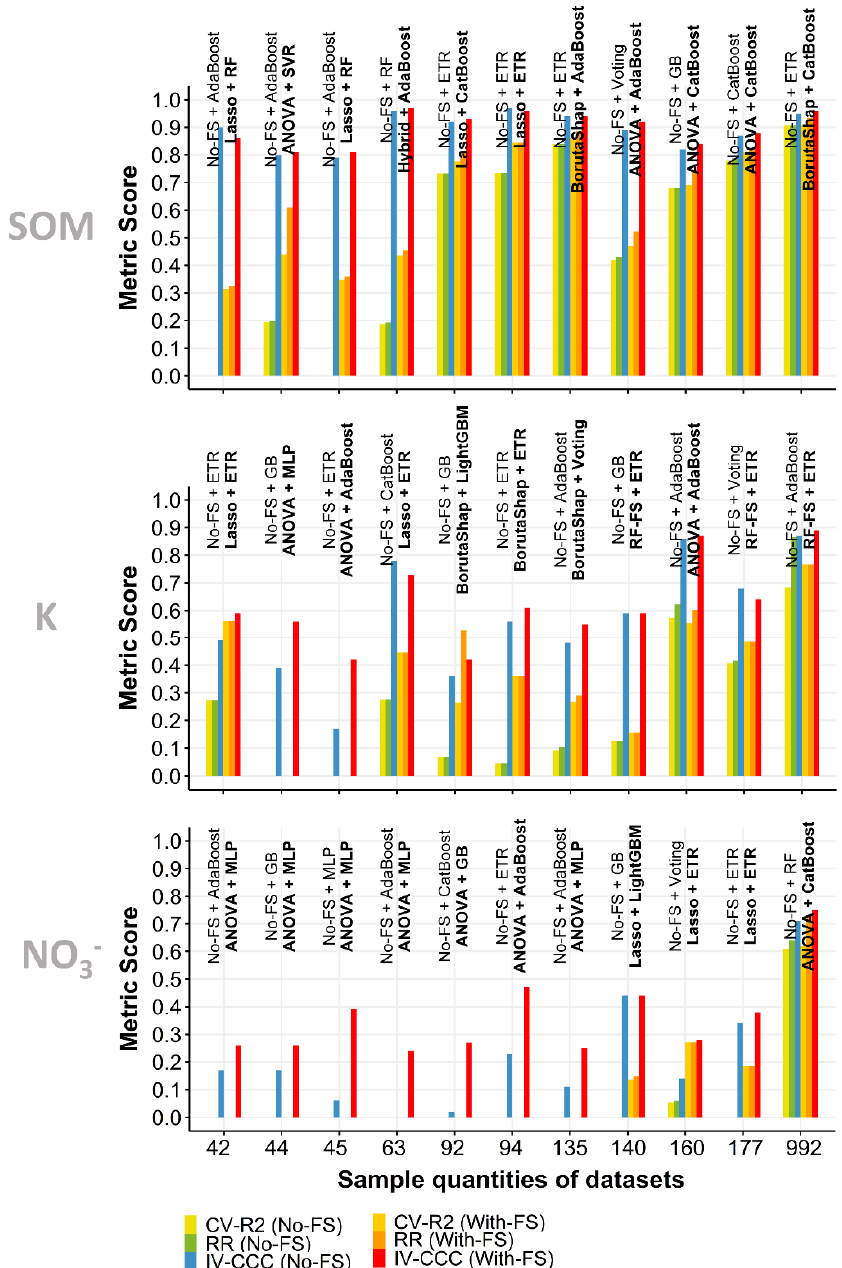
Figure 7. Comparisons of No-FS models and the models with optimal combinations of FS and ML for SOM, K, and NO 3 − . There are six bars per sample set for each soil property. Sample sets are labeled and ordered by the quantity of samples in the set. The first three bars represent the evaluation metrics for No-FS models, while the latter three bars are for the optimal FS-ML combination. The models from both categories are obtained by applying the evaluation procedure (Figure 2). Annotations in plain and bold text for each corresponding sample set are the No-FS models (plain) and the optimal FS-ML combination models (bold). Out of eleven sample sets tested, IV-CCC scores for models that utilized FS were higher than the No-FS models for nine (SOM), eight (K), and eleven (NO 3 − ) sample sets.